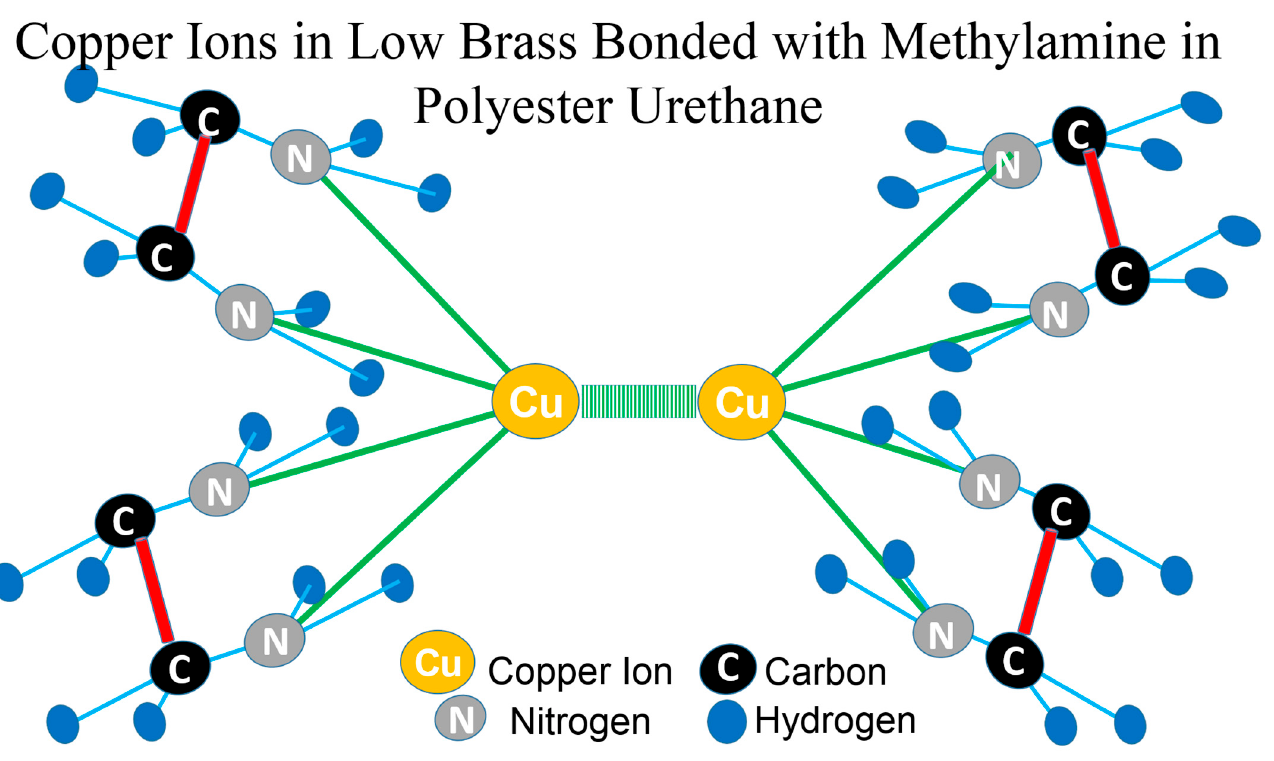
Figure 3. Illustration diagram of copper ions in low brass bonded with methylamine in polyester urethane.